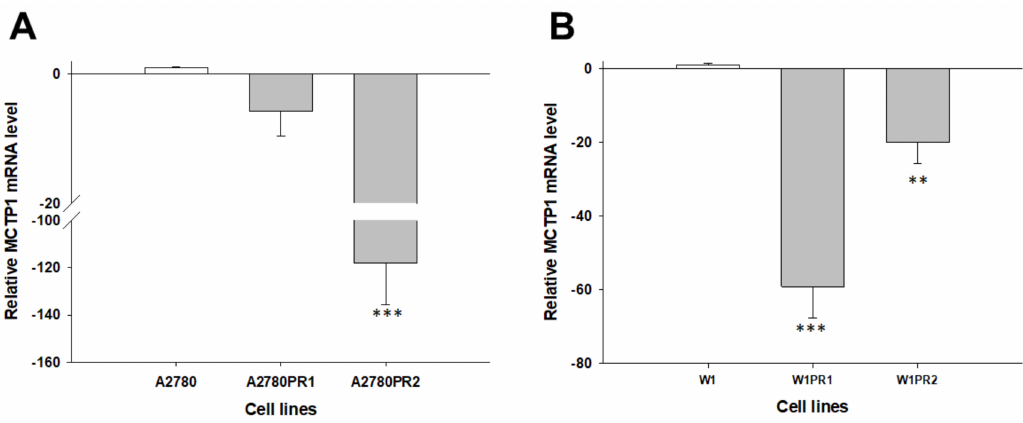
Figure 3. Expression analysis (Q-PCR) of the MCTP1 gene in the A2780 ( A ) and W1 ( B ) PAC-resistant cell lines. The figure presents the relative gene expression in the resistant cell lines (grey bars) with respect to that of the sensitive cell line (white bars), which was assigned a value of 1. The values were considered significant at ** p < 0.01 and *** p <